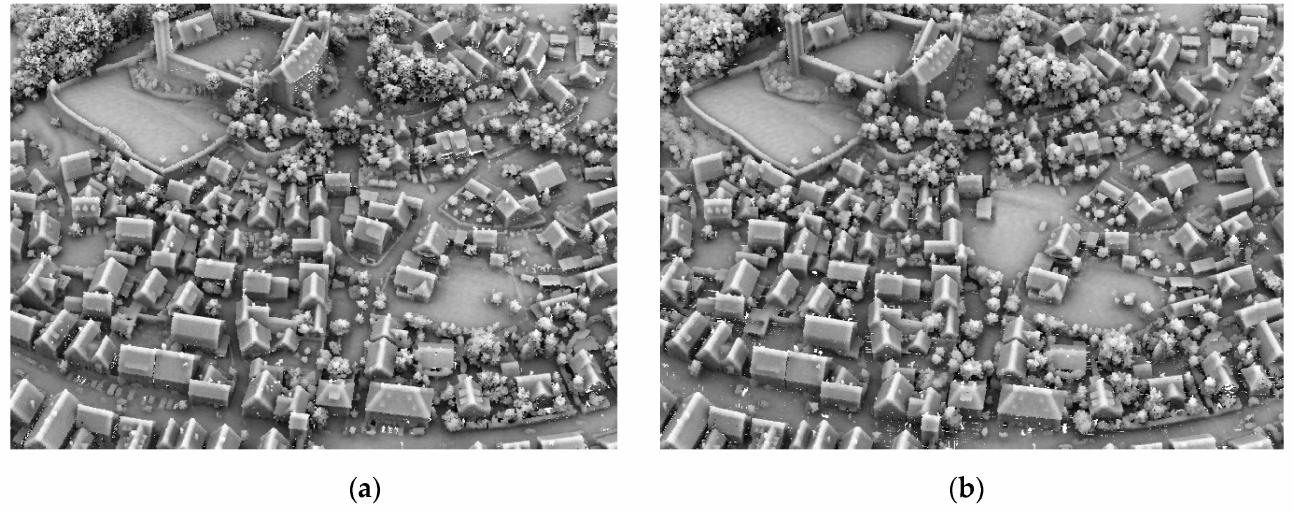
Figure 13. ( a ) Adenberg data 2008 and ( b ) Adenberg data